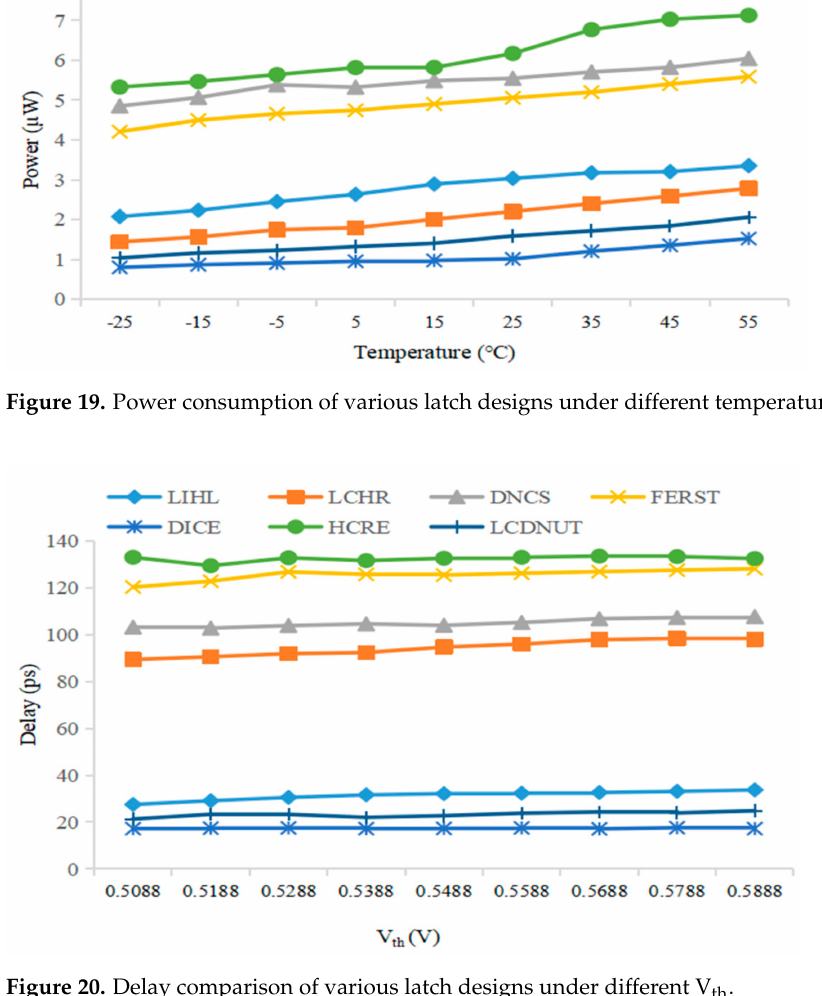
Figure 20. Delay comparison of various latch designs under different V th